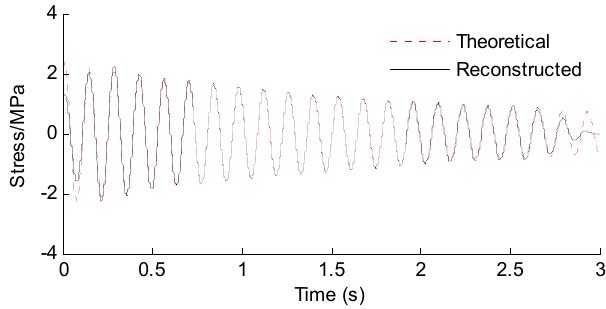
Figure 11. Reconstructed and theoretical bending stress responses for the Loc. I labeled in Figure 7.